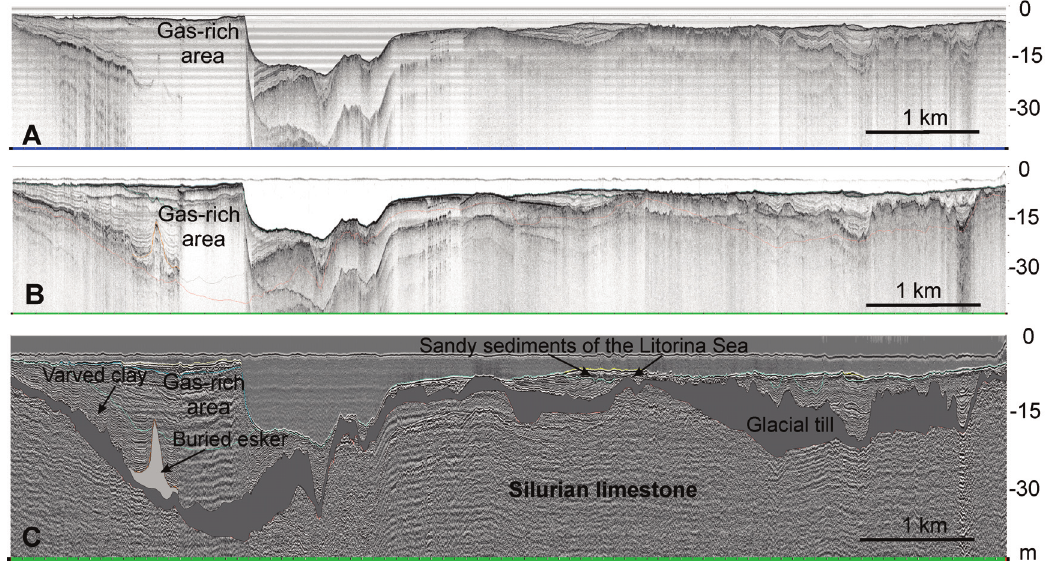
Fig. 2. Examples of the recordings of a profile south of Kesselaid (Profile 2 in Fig. 1B) based on the different seismo-acoustic sound sources and pulse frequencies: (A) – high-frequency chirp, (B) – boomer with the full frequency band and (C) – boomer with the filtered high-frequency portion. For interpretation of this profile, see Fig.